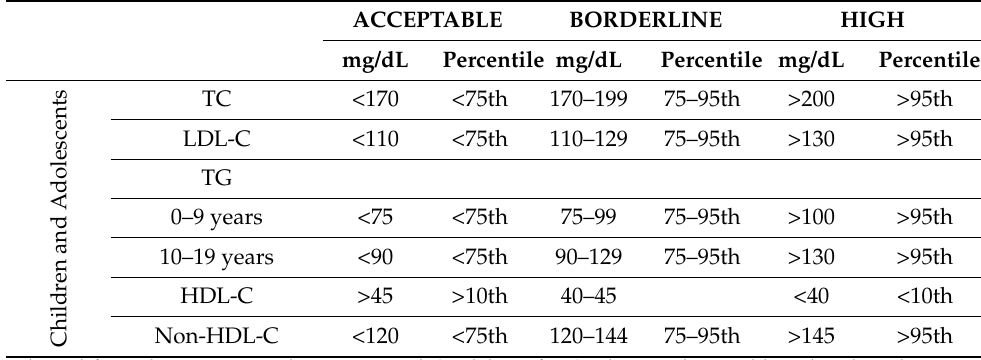
Table 1. Lipid and lipoprotein reference values and corresponding centile in children and